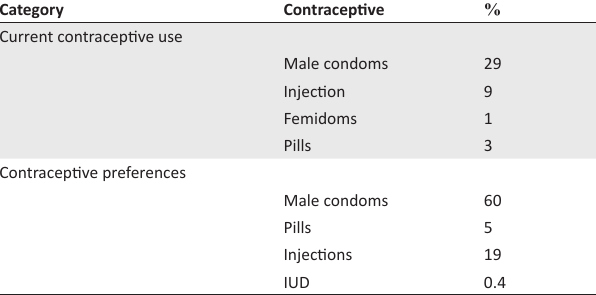
TABLE 2: Contraceptive use and preferences. Category